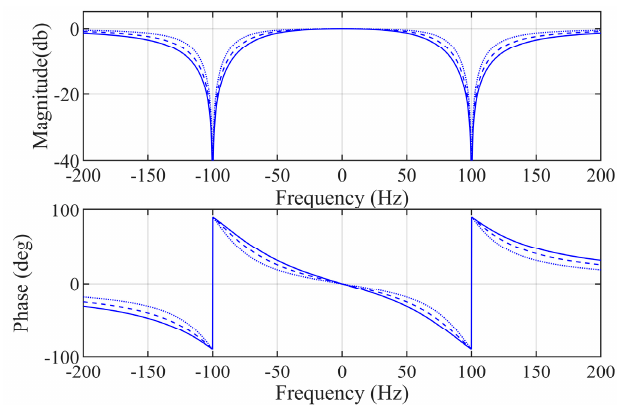
Figure 5. Bode plot of ANF part in filtering stage. ξ = 0.5 (dotted lines), 0.7 (dashed lines), 0.9 (solid lines).